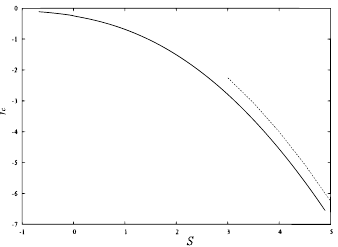
Figure 8. Plot of the critical values γ c against S , asymptotic expression (4.12) is shown by the broken